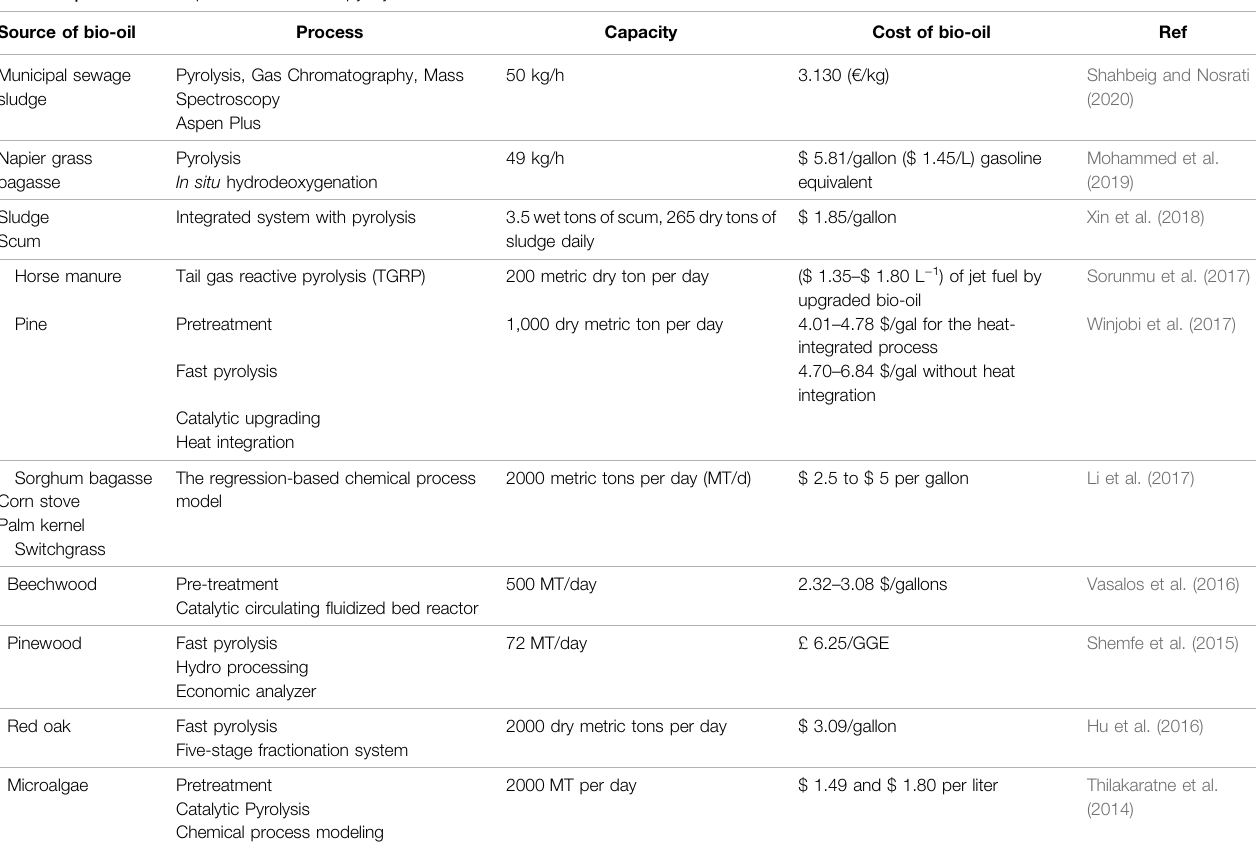
TABLE 3 | Cost of bio-oil produced from fast